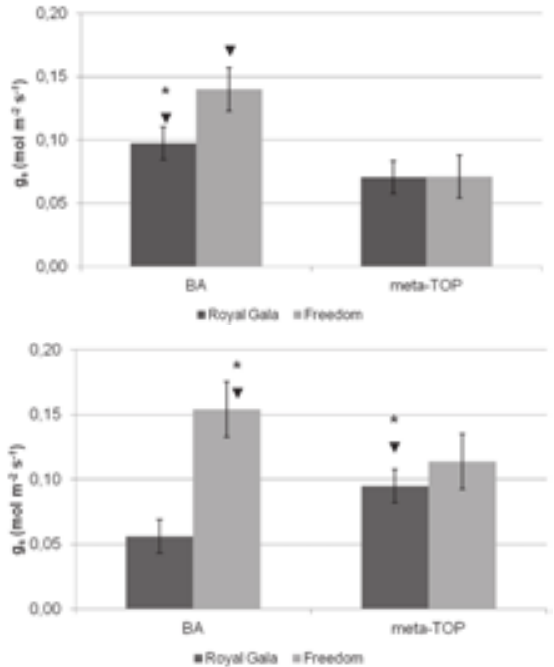
Figure 4. Effects of different cytokinins and apple cultivars on stomatal con- 2 ductance of water vapour (g ) at (A) 2.0 µM and (B) 6.0 µM cytokinin supply. s *: means significant (P ≤ 0.05) differences between the apple scion cultivars (‘Royal Gala’ and ‘Freedom’) at the same cytokinin type; ▼ : means significant (P ≤ 0.05) differences between the cytokinin types (BA and meta-TOP) in the same scion